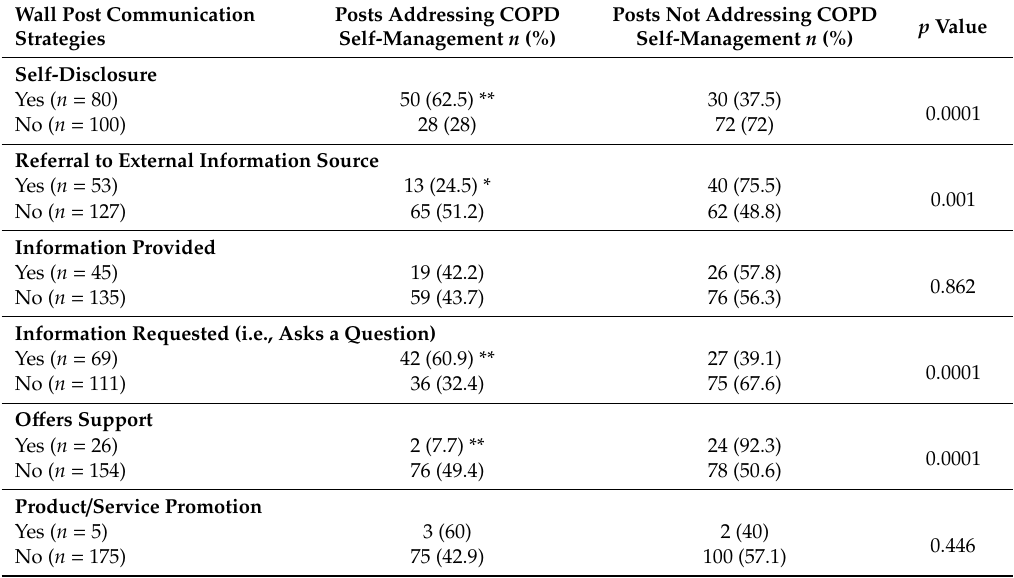
Table 4. Frequency of wall post content ( n = 180) of 26 COPD Facebook Groups according to whether or not wall post addressed any self-management